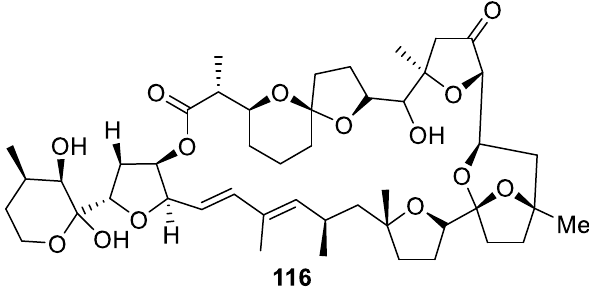
Figure 53. Erectile function-potentiating toxin featuring a [4.5.0] spirocyclic motif.